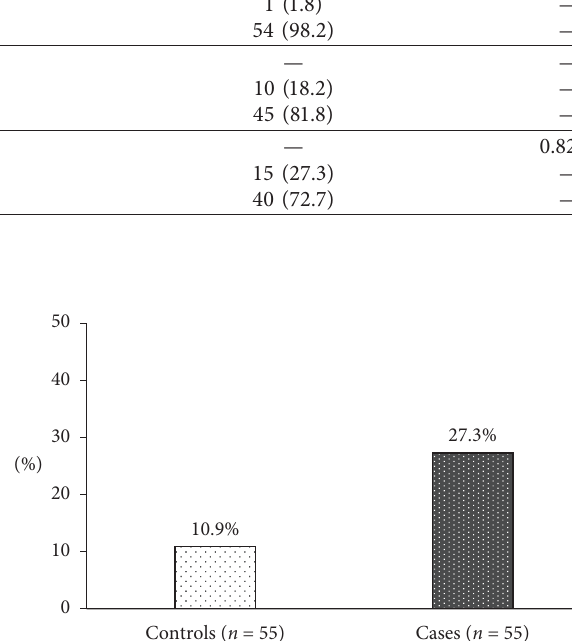
Figure 1: The percentage of the positive test for H . pylori in matched case and control subjects. The portion was significantly different among cases and controls ( p � 0 .